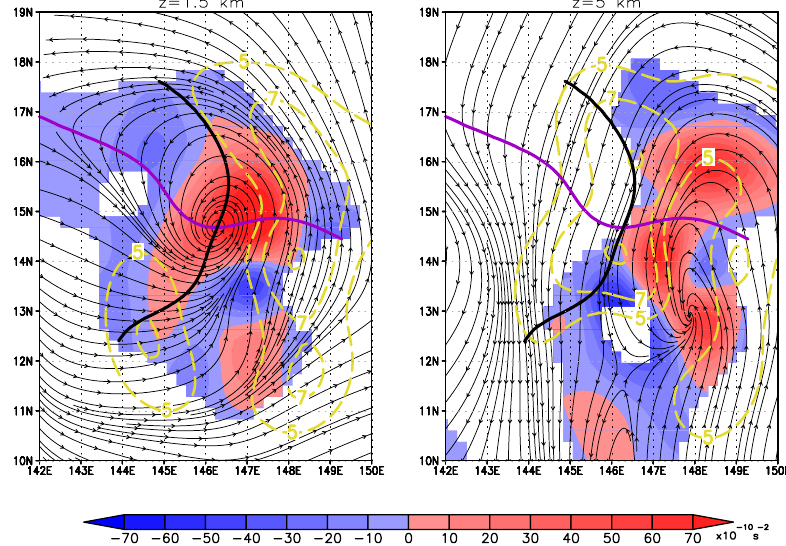
Figure 5. Two-panel plot of Okubo–Weiss (OW, shaded) and streamlines (co-moving) for Nuri 1 at 1.5km (left) and 5km (right) height from the 25km SAMURAI analysis. The thick purple line indicates the position of the 1.5km critical latitude and the thick black line indicates the position of the 1.5km wave trough. The dashed yellow lines are isotachs contoured at 2ms − 1 intervals. The OW is only shaded in regions with cyclonic relative vorticity. The abscissa is longitude and the ordinate is latitude.